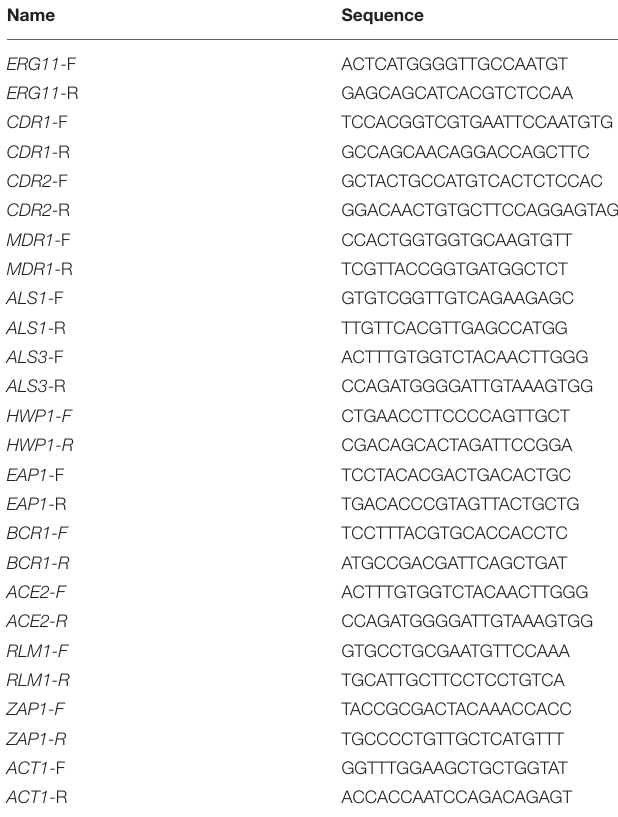
TABLE 1 | Primers for real-time RT-PCR (5 ′ to 3 ′ ).